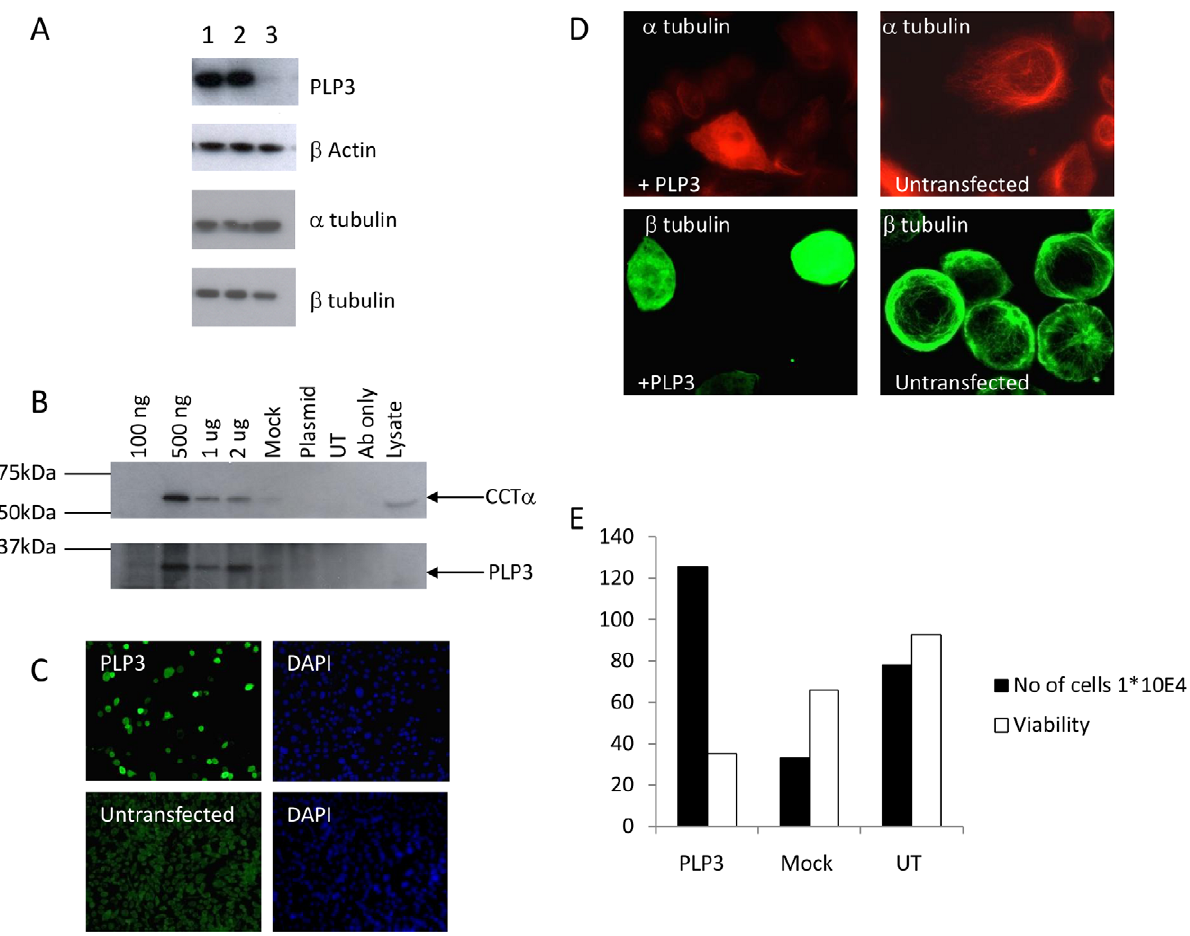
Figure 1. Transient expression of PhLP3 in CHOK1 adherent cells promotes tubulin redistribution, an imbalance of a and b -tubulin subunits and cell death. (A) Anti-PhLP3antibodydetects fulllengthPhLP3(24 kDa)inCHOK1adherentcells transiently transfected withhumanPhLP3 (duplicates lane 1 and 2). Endogenous PhLP3 was detected in the plasmid only control (lane 3). b -actin levels are not altered upon PhLP3 overexpression but this promotes an increase of b -tubulin subunits relative to the control and a decrease in a -tubulin subunits (compare lanes 1 and 2 with lane 3). (B) Immunoprecipitation of CCT a in CHOK1 cells transiently transfected with PhLP3. CCT a (top panel) and PhLP3 (bottom panel) were detected in cell lysates transiently transfected with 500 ng–2 m g PhLP3 plasmid and immunoprecipitated with an anti-PhLP3 antibody, but not in plasmid only, untransfected and antibody only controls. (C) Immunofluorescent detection of PhLP3 in CHOK1 cells transfected with PhLP3. An anti-PhLP3 antibody was used to identify cells overexpressing PhLP3 (green) and DAPI (blue). (D). PhLP3 overexpression alters tubulin distribution. Immunofluorescent staining of PhLP3 transfected CHOK1 cells with either anti- a tubulin(red) or anti- b tubulin(green) specific antibodies detects redistribution of both tubulin subunits compared to untransfected controls. (E) PhLP3 overexpression in adherent CHOK1 cells promotes the release of cells into the supernatant and decreases cell viability compared to mock transfected and untransfected controls. Data calculated as mean + / 2 SEM of n=2.